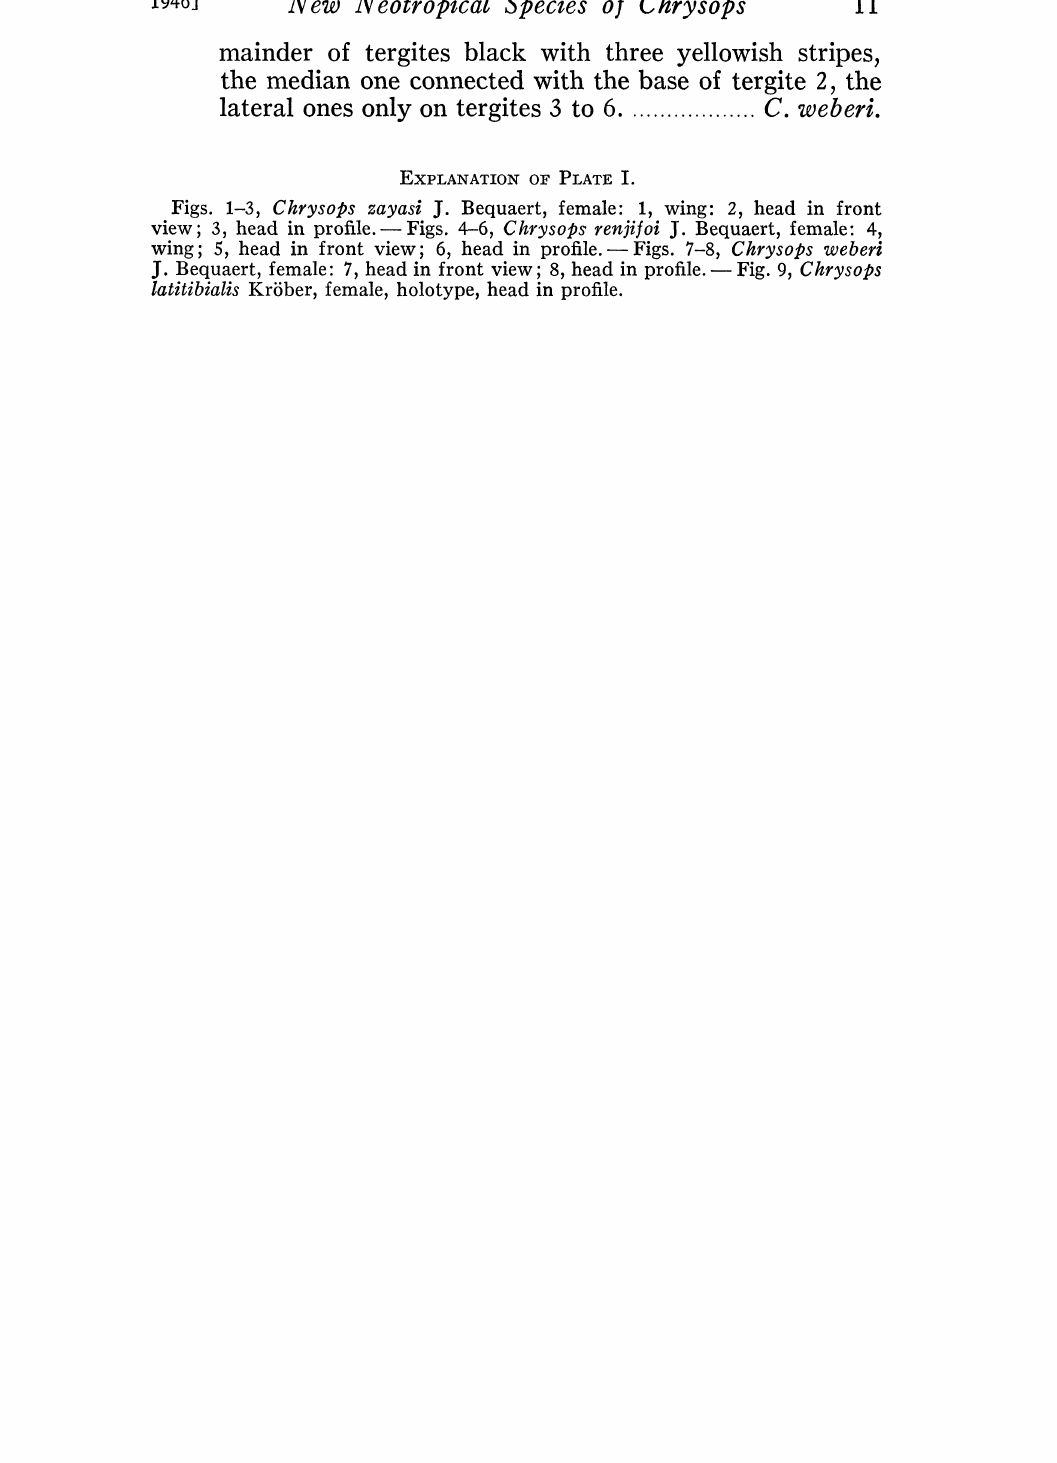
Figs. 1-3, Chrysops zayasi J. Bequaert, female: 1, wing: 2, head in front view; 3, head in profile. Figs. 4-6, Chrysops renfifoi J. Bequaert, female: 4, wing; 5, head in front view; 6, head in profile.--Figs. 7-8, Chrysops